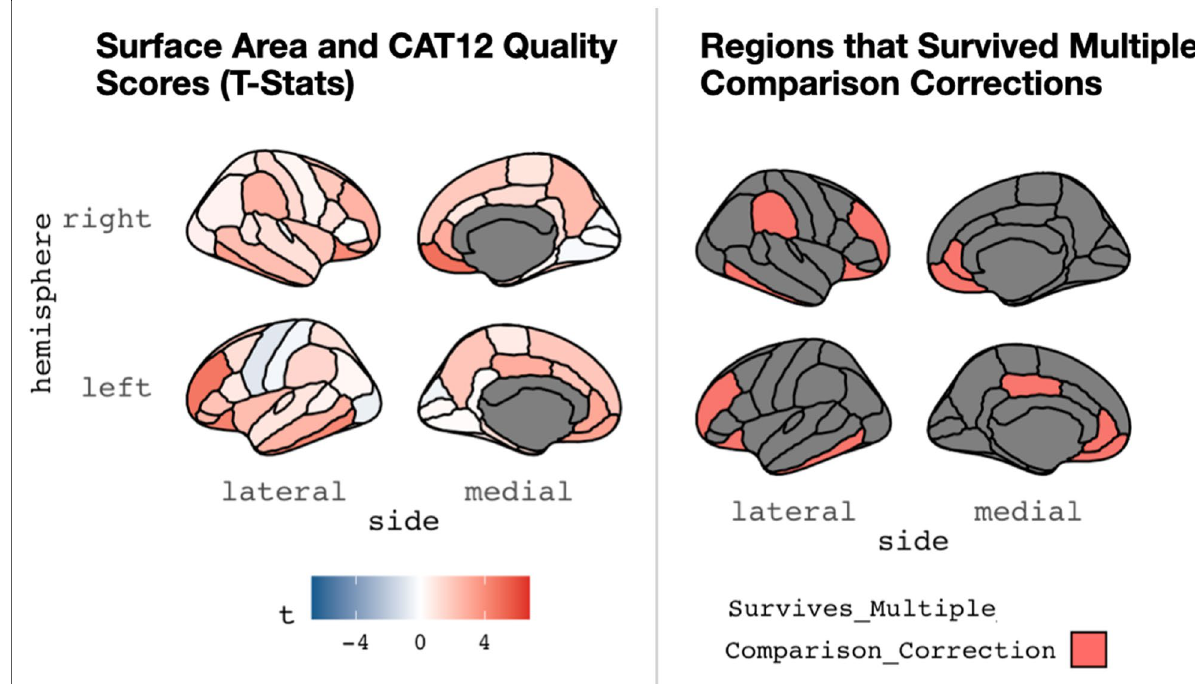
Fig. 5 A graphic depiction (from the R library ggseg ) showing associations between image quality (assessed by the CAT12 Toolbox) and derived (mean) cortical surface area. This is shown for the DK atlas commonly used in Freesurfer. Lateral and medial views are shown for the right (top) and left (bottom) hemispheres. The left panel shows the overall t-statistics for the relation in each parcel, while the right panel shows parcels where the relation between surface area and image quality survives multiple